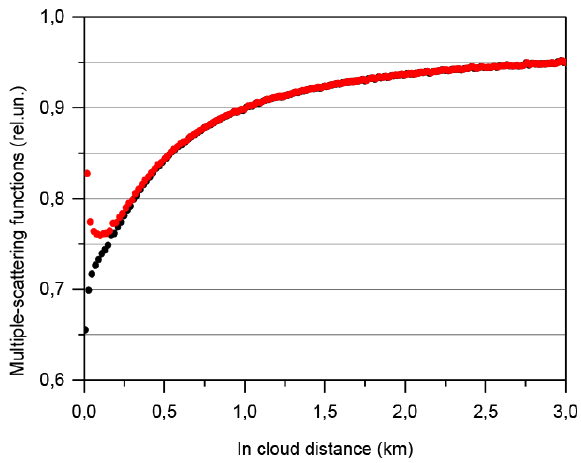
Figure B2. Multiple-scattering function η MS (h i ) : h i assigned to the middle (black points) and to the end (red points) of the range